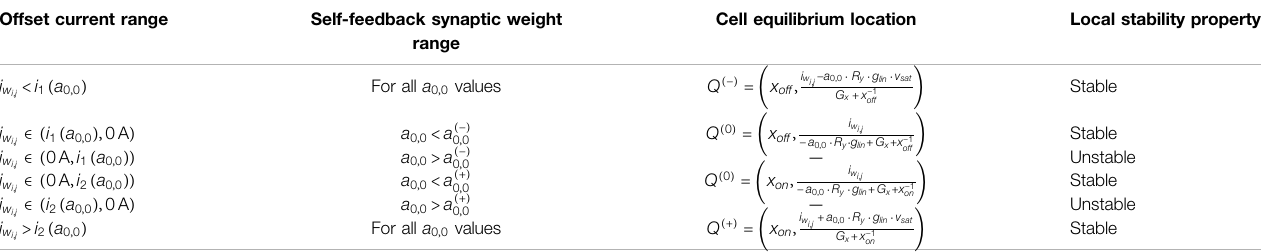
TABLE 4 | Location and local stability property of each of the equilibrium points, which a M-CNN cell may possibly admit, depending upon a 0 , 0 and i w equilibria Q (−) , Q ( 0 ) , Q ( 0 ) , and Q (+) are respectively speci fi ed in Eqs. 39 , 41 , 43 , and 45 . The formulas for a (−) 0 , 0 , a (+) 0 , 0 , i 1 ( a 0 , 0 ) , and i 2 ( a 0 , 0 ) are respectively expressed by Eqs. 37 , 38 , 53 , and 54 . The local stability nature of each of the possible cell equilibria is also revealed. The analysis of the marginal cases is omitted from this